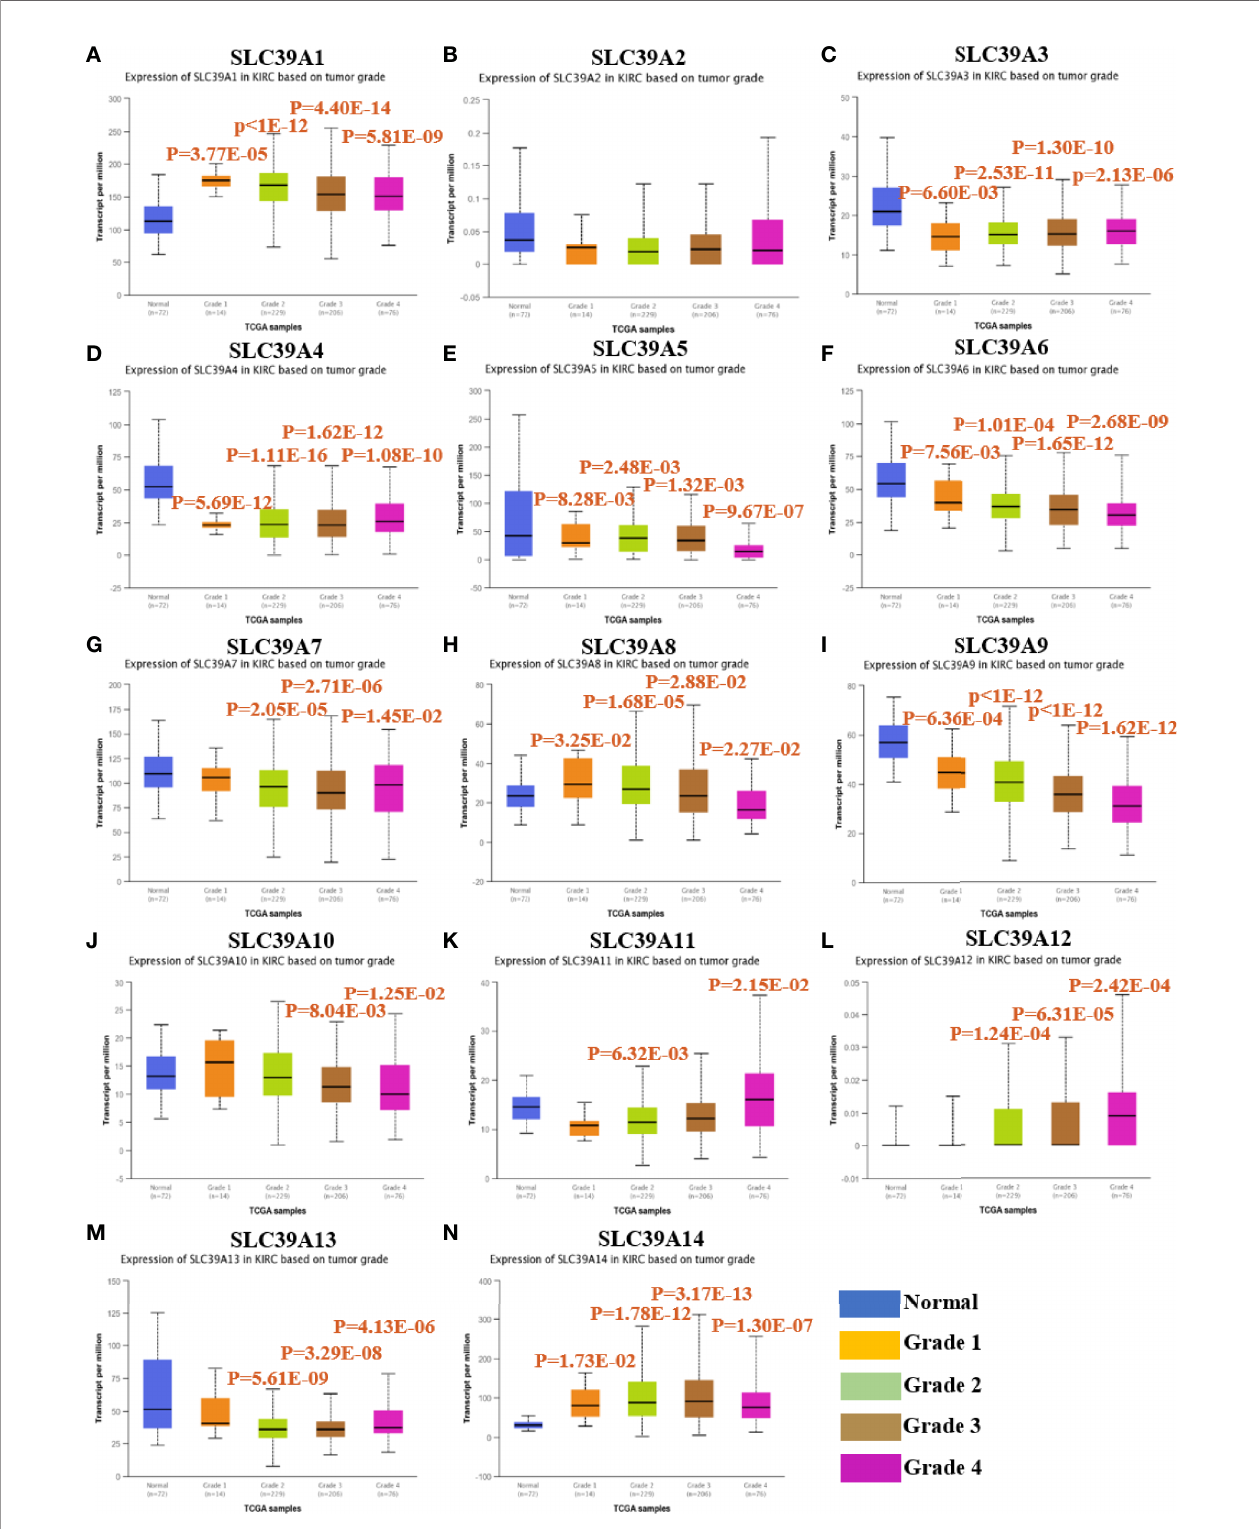
FIGURE 1 | The expression of ZIP family genes based on tumor grade in patients with ccRCC by using UALCAN database 40 . (A – N) SLC39A1, SLC39A2, SLC39A3, SLC39A4, SLC39A5, SLC39A6, SLC39A7, SLC39A8, SLC39A9, SLC39A10, SLC39A11, SLC39A12, SLC39A13, SLC39A14. Mean differences were considered statistically signi fi cant when P